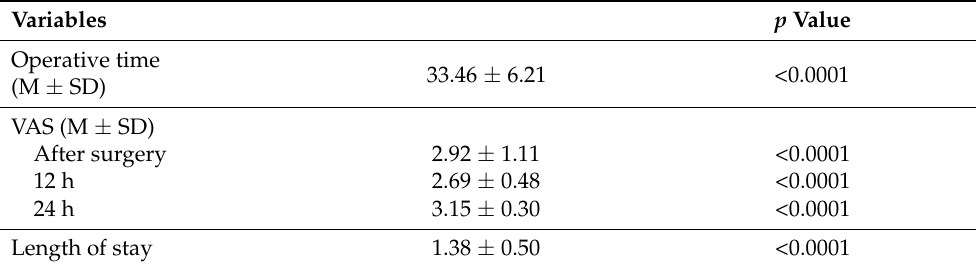
Table 2. Perioperative